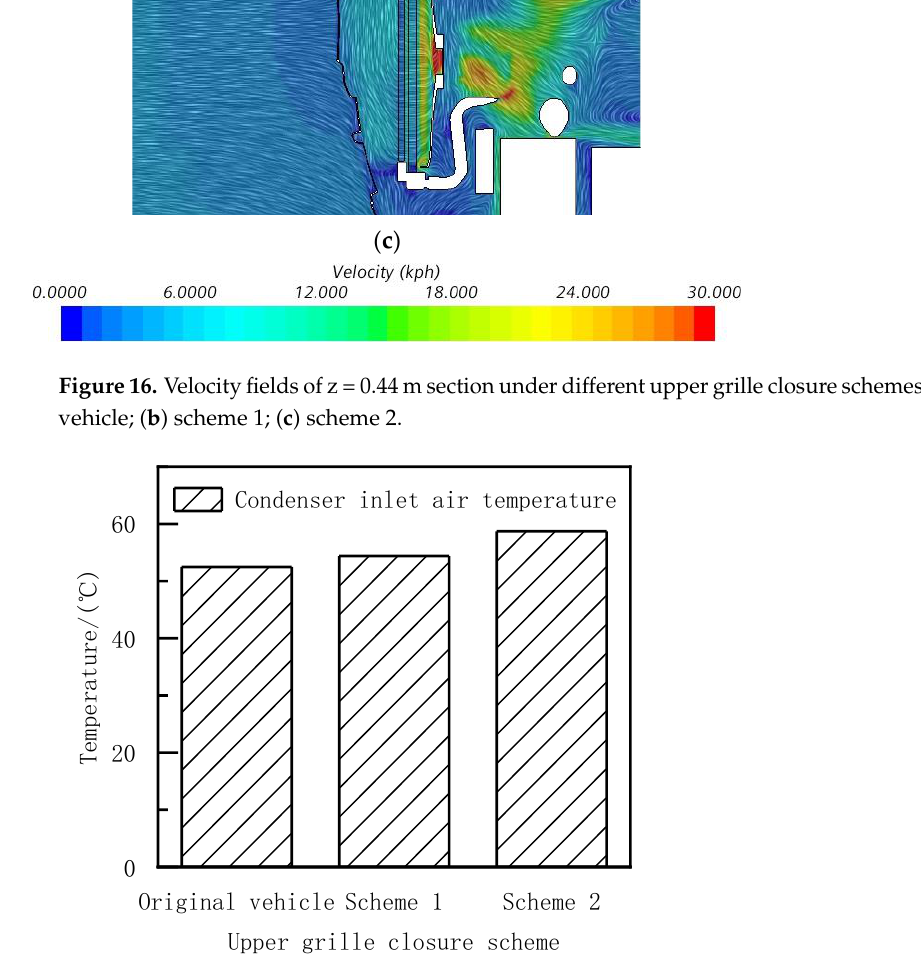
Figure 17. Comparisons of the condenser inlet temperature under different upper grille schemes.